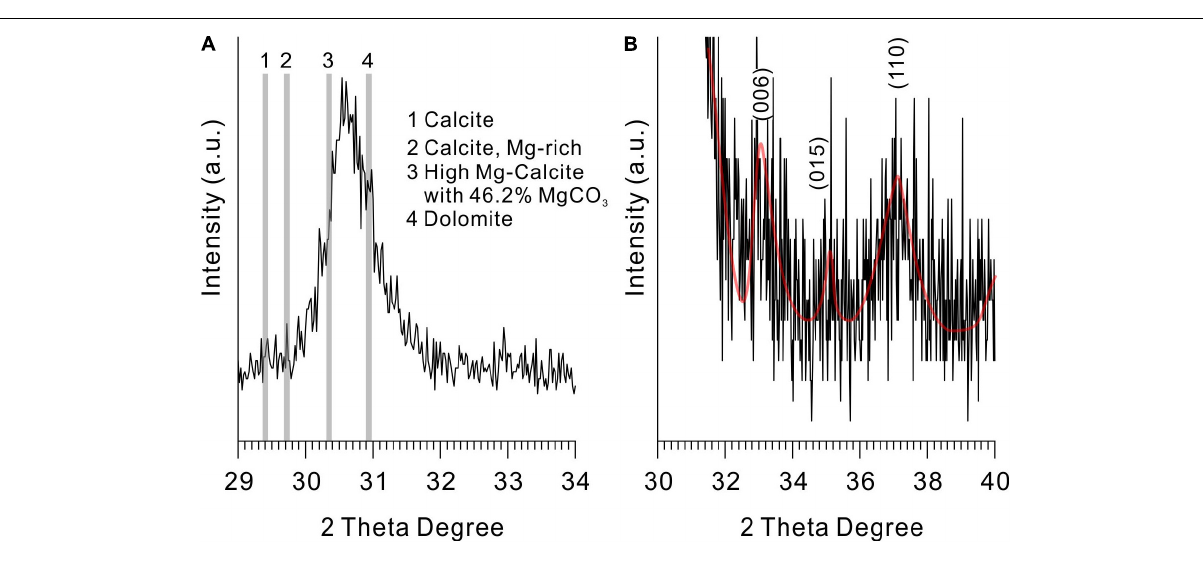
FIGURE 5 | X-ray diffraction spectra of protodolomite induced by QPL2 at a Mg/Ca molar ratio of 12. (A) The 2 θ position of the (104) face of protodolomite induced by QPL2 and comparison with other Mg-containing carbonate minerals and (B) simulated (006), (015), and (110) faces of protodolomite induced by QPL2. The data for standard calcite, Mg-rich calcite, and dolomite are from the MDI Jade 6.5 database [PDF#47-1743, PDF#43-0697, and PDF#36-0426); the data for high-magnesium calcite are from Zhang et al.